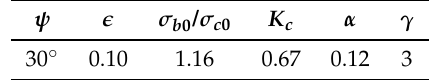
Table A3. Values used for the Concrete Damaged Plasticity model from Abaqus FEA